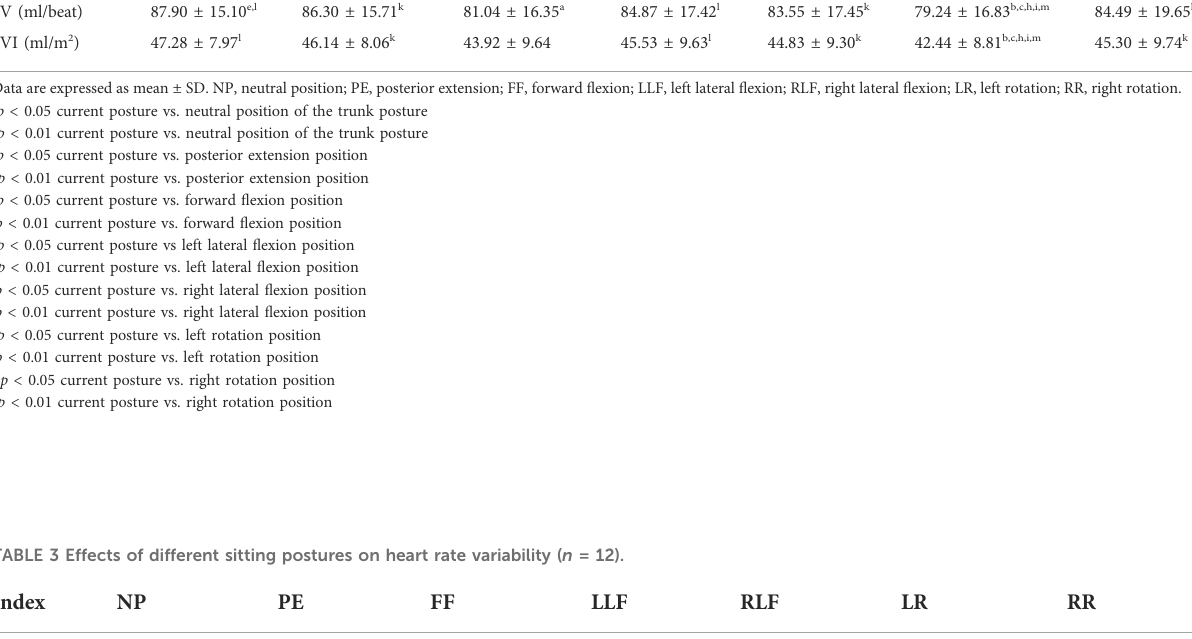
TABLE 3 Effects of different sitting postures on heart rate variability ( n = 12).